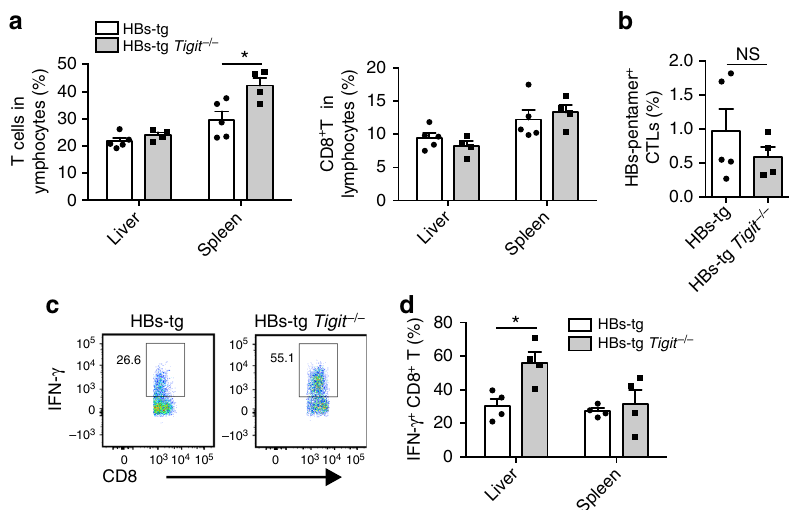
Fig. 7 Functional tolerance of hepatic CD8 + T cells cannot be maintained in HBs-tg Tigit − / − mice. a The percentage of total T cells and CD8 + T cells in the liver and spleen of HBs-tg Tigit − / − and control HBs-tg mice ( n = 5, 4; HBs-tg, HBs-tg Tigit − / − ). b The percentage of hepatic HBsAg-speci fi c CTLs (7-AAD − CD3 + NK1.1 - CD8 β + HBsAg-pentamer + ) among CD8 + T cells in HBs-tg Tigit − / − and control HBs-tg mice is shown ( n = 5, 4; HBs-tg, HBs-tg Tigit − / − ). c Intracellular IFN- γ staining of hepatic CD8 + T cells from naïve 10-month-old HBs-tg Tigit − / − and control HBs-tg mice in response to stimulation with PMA and ionomycin. d The statistical percentages in ( c ) are shown ( n = 4 in each group). Statistically signi fi cant differences between the groups are presented as the mean ± SEM. NS, not signi fi cant; * P < 0.05 (two-tailed unpaired Student ’ s t -test). Data are representative of three independent